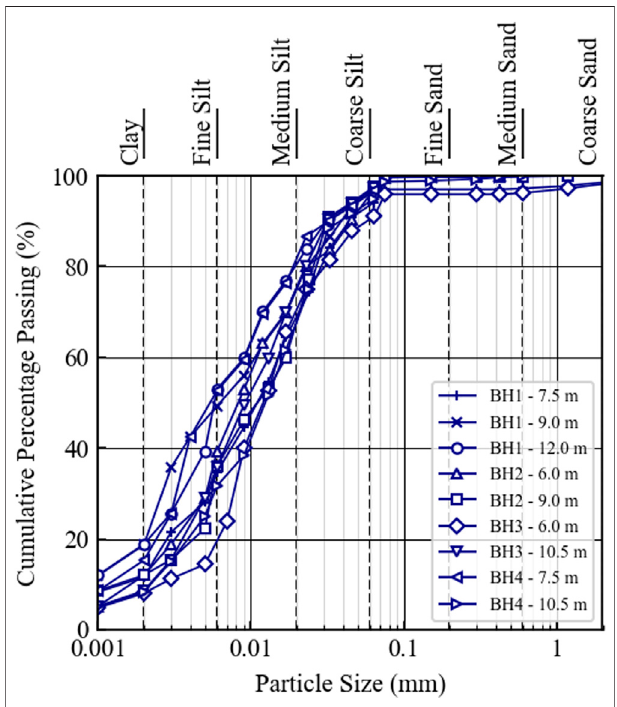
FIGURE 9 | Particle size distribution data from boreholes at site 06- Chyasal (Chys_2015) (SAFER/GEO-591; Gilder et al., 2019a; Gilder et al., 2020) at 6.0 – 12.0 m depth.